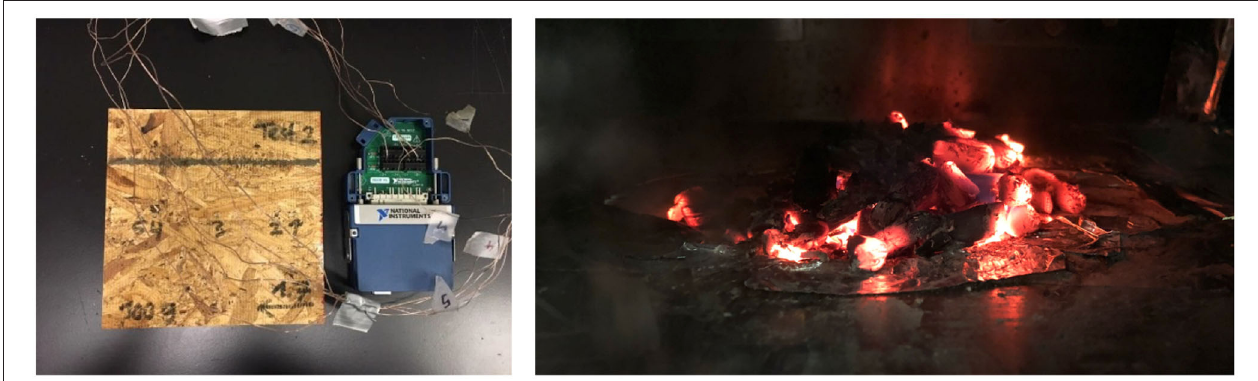
FIGURE 3 | (Left) Photograph of a sample of plywood instrumented with thermocouples and attached to the DAQ card used in the experiment and (right) a representative smoldering firebrand pile with wind flowing from right to left.